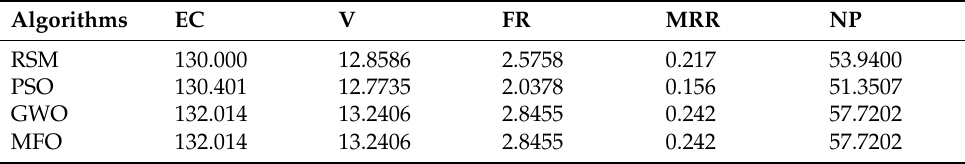
Table 13. Optimum process parameters and the response